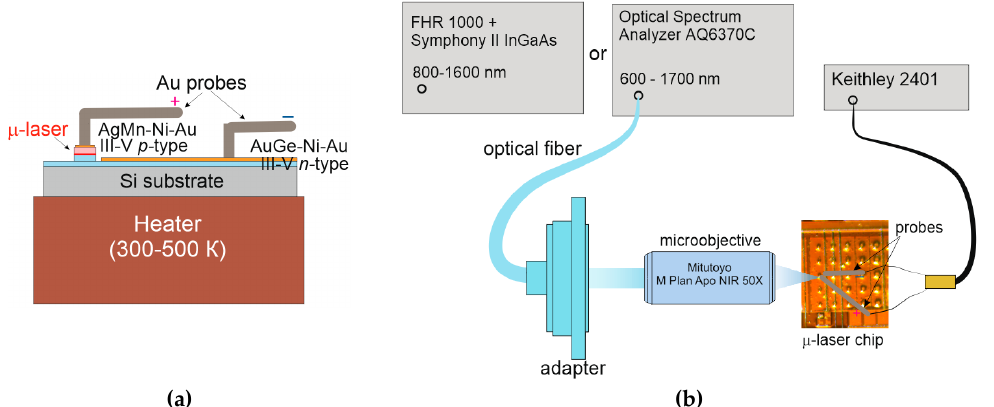
Figure 3. Microdisk electrical connection scheme ( a ) and sketch of optical measurement system ( b ).